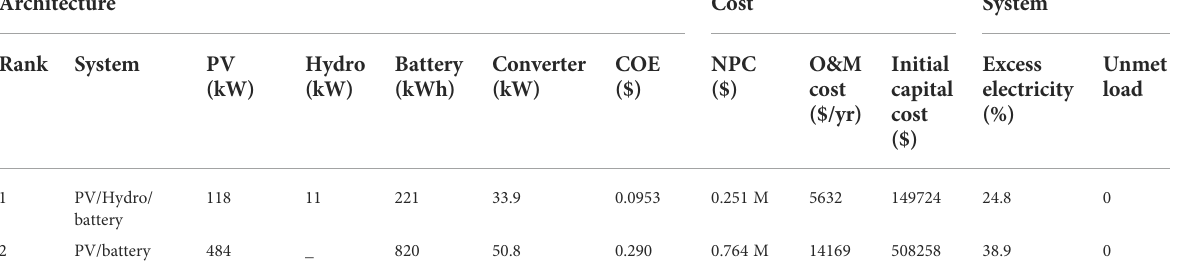
TABLE 3 Optimization result of the hybrid system.